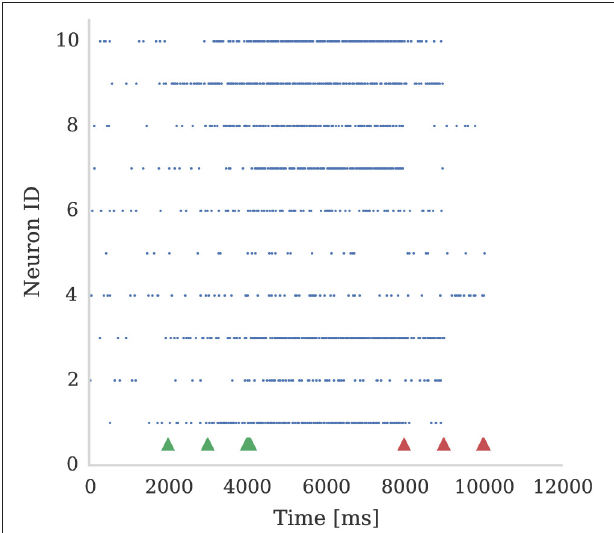
FIGURE 3 | The strength of a single synapse after delayed reward and punishment. Each data point represents a separate experiment with a single pre-synaptic neuron connected to two post-synaptic neurons. A single pre-synaptic spike at time 1ms is fired which causes both post-synaptic neurons to fire at time 3 ms. A single dopaminergic spike with D c = 0.1 for reward and D c = − 0.1 for punishment is fired at different times between 4 and 3,000 ms. All the parameters are set to the values shown in Tables 1 , 2 . It can be seen that the longer dopamine is delayed, the more the eligibility trace decays and thus the smaller the resultant weight change. When the eligibility trace decays to zero at around 2,400 ms, the synapses are no longer affected by dopamine release.